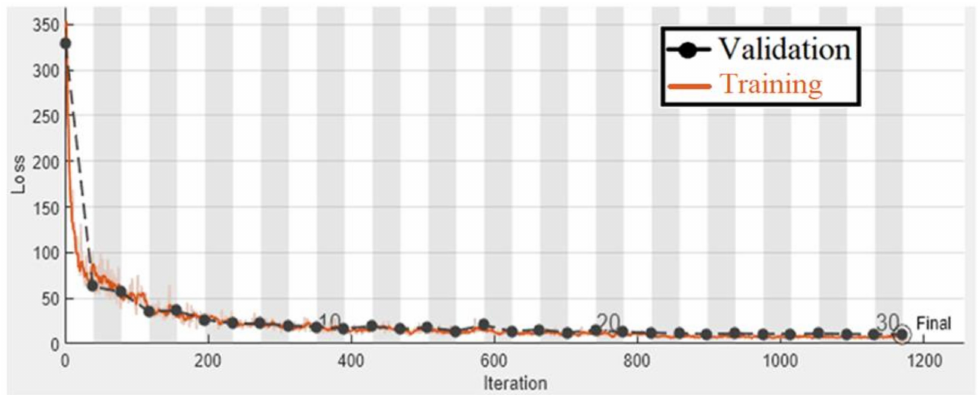
Figure 14. Training and validation RMSE plot of the eye gaze direction estimation model.